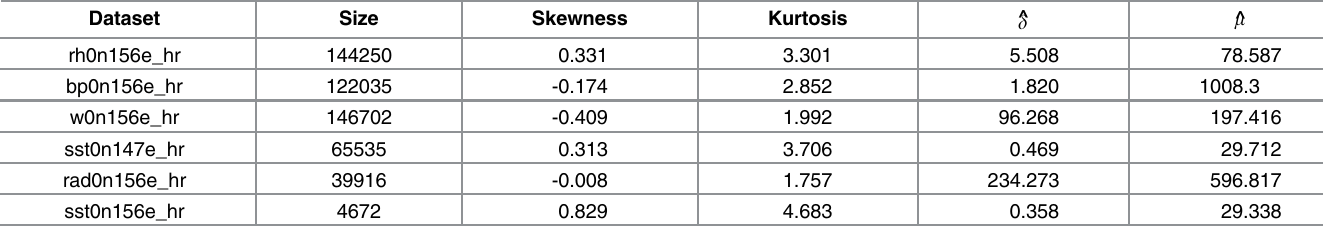
Table 3. General description of